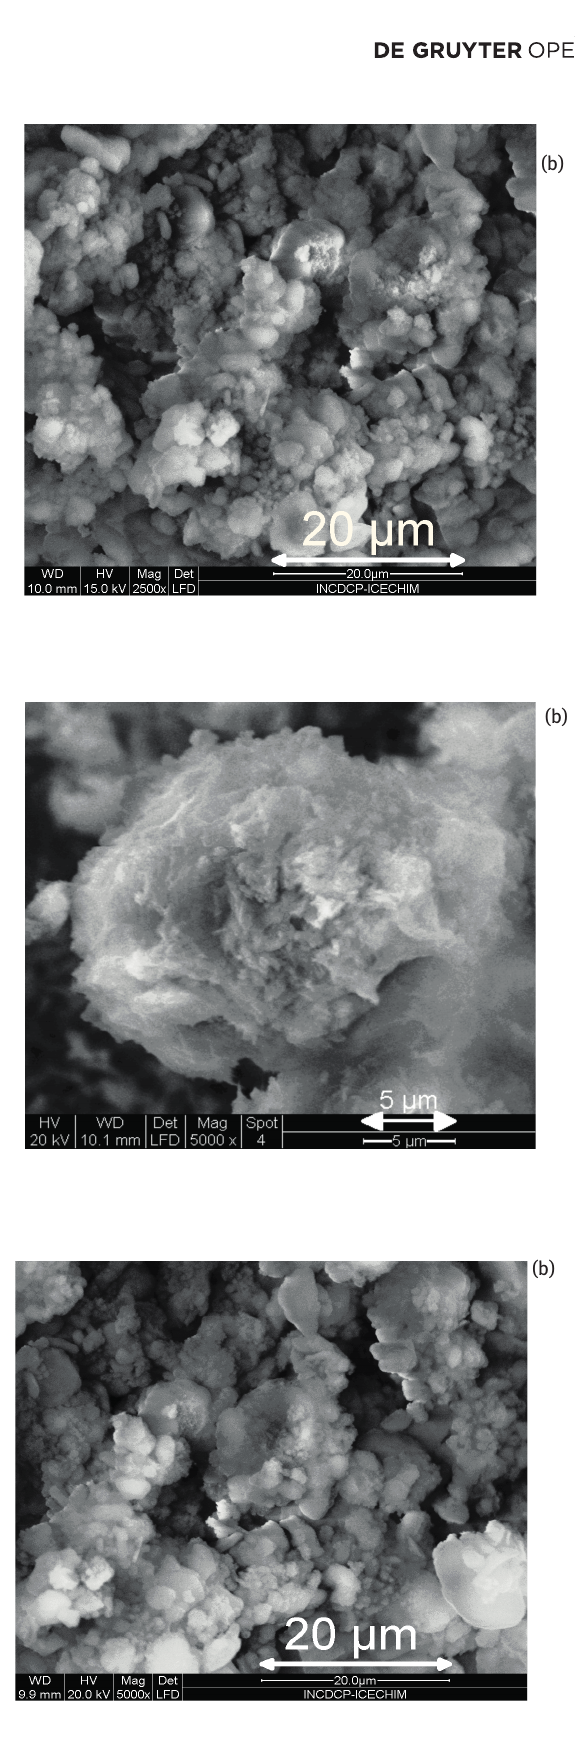
Figure 4: SEM image of NPK 211 fertilizer (d